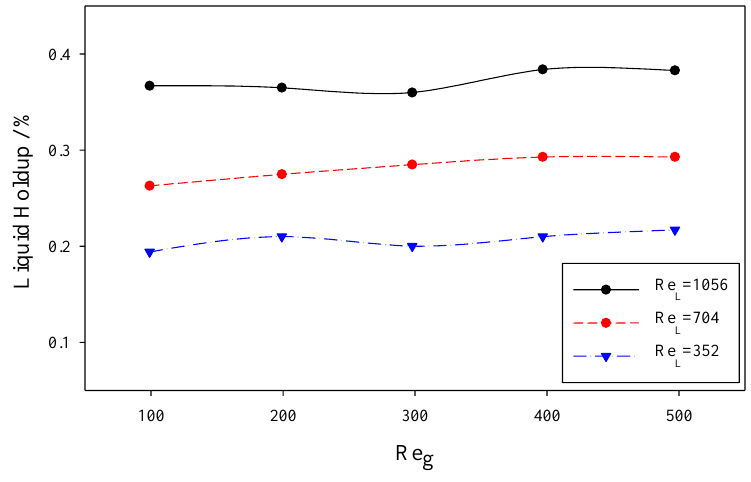
Figure 7. Influence of gas velocity with fixed liquid velocities on liquid hold up.